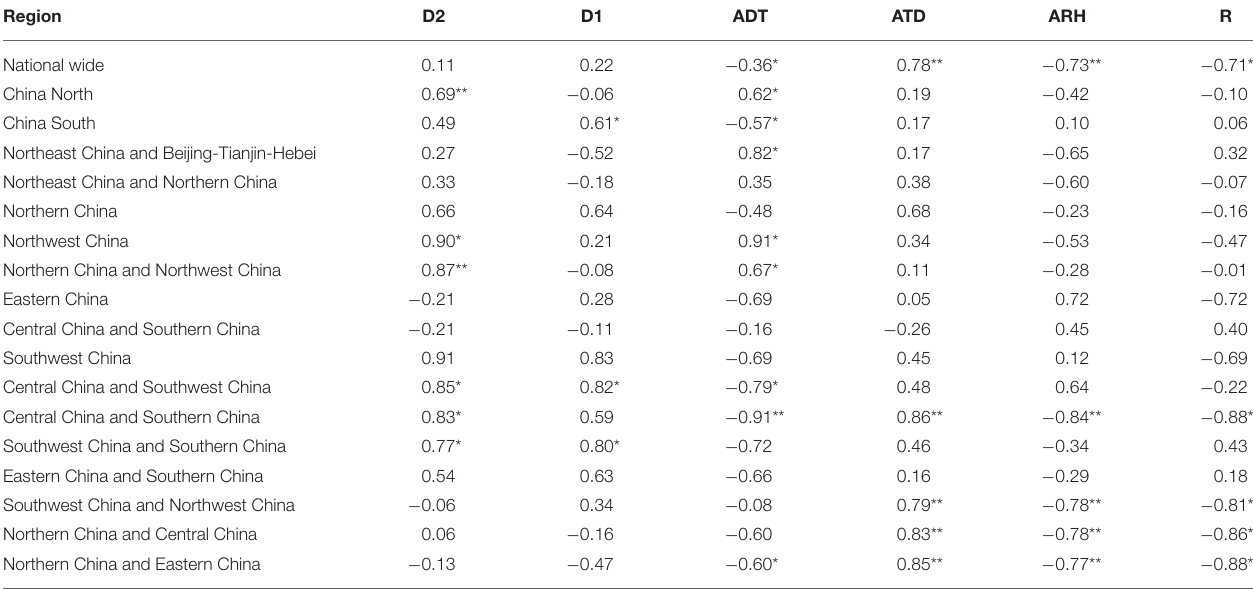
TABLE 3 | Coefficients of correlation between pepper yield and climatic factors in different ecological regions of China. Region D2 D1 ADT